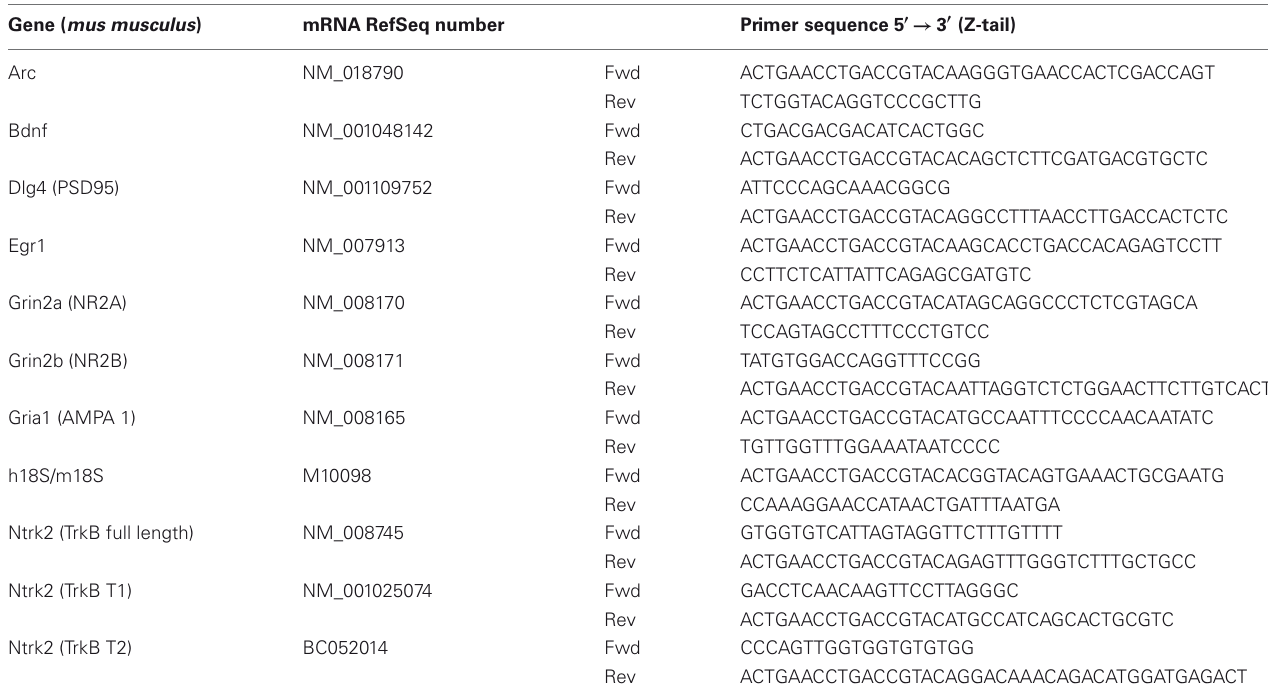
Table 2 | Primers sequence for real time